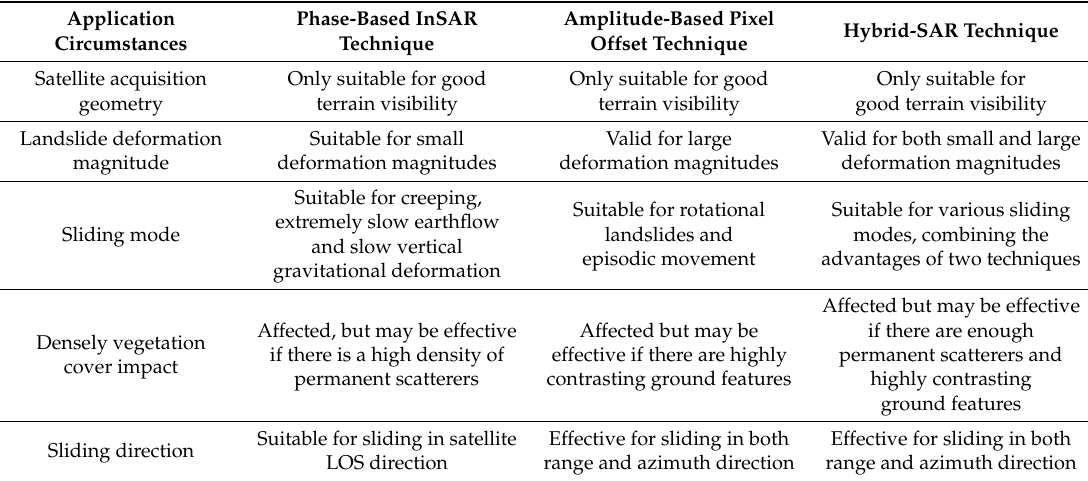
Table 5. Application circumstances for the phase-based InSAR technique, amplitude-based pixel offset technique and hybrid-SAR